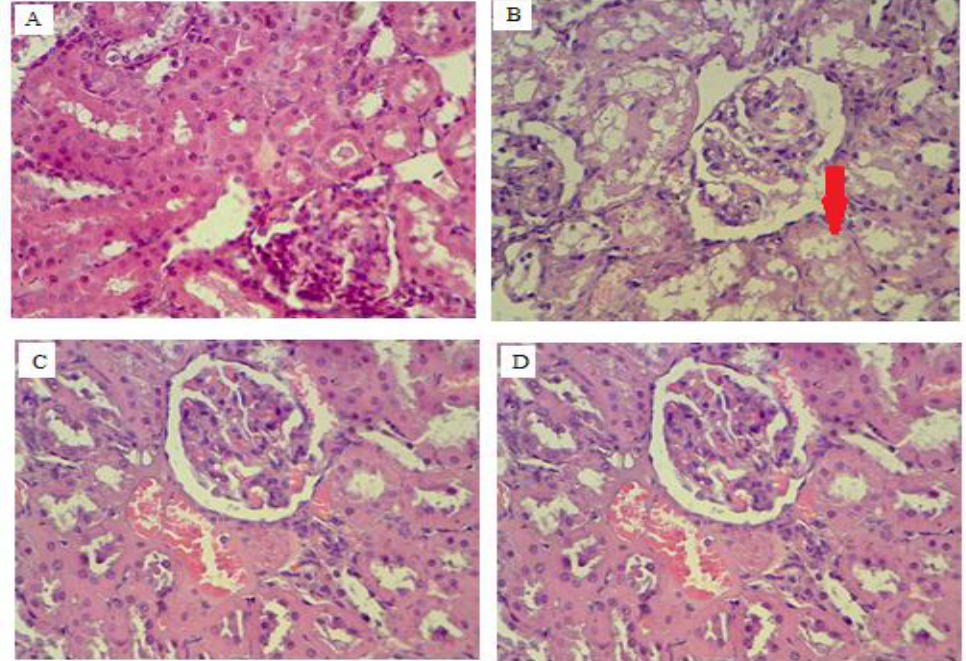
Figure 1. Influence of guggulsterone (GS) administration on patho-histological structure of kidney in Cyp- induced toxicity in rats. Photo-micrographs of hematoxylin and eosin-dyed kidney sections (400X) viewing: (A) control, (B) Cyclophosphamide group, (C) Cyclophosphamide + guggulsterone administration group and (D) guggulsterone (GS) only groups .